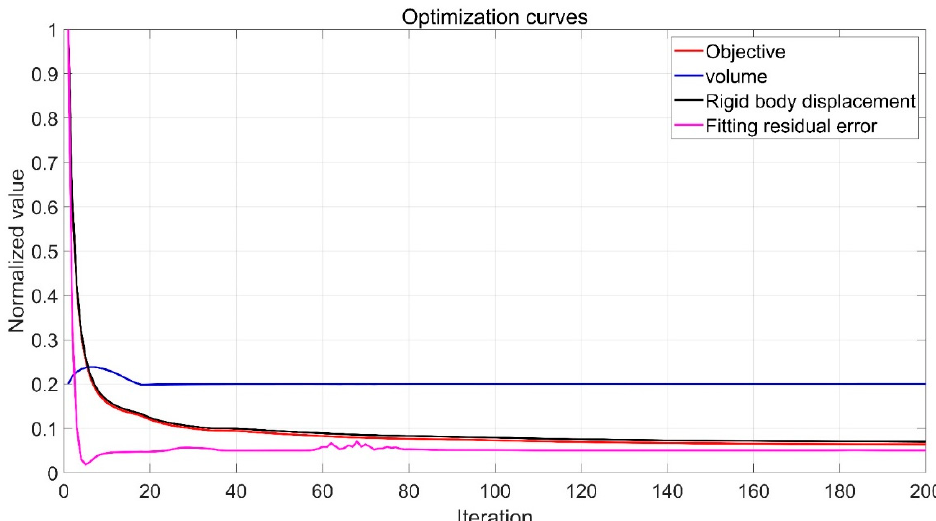
Figure 9. Iterative curves of the normalized objective and constraints in the vertical condition of the optical axis.